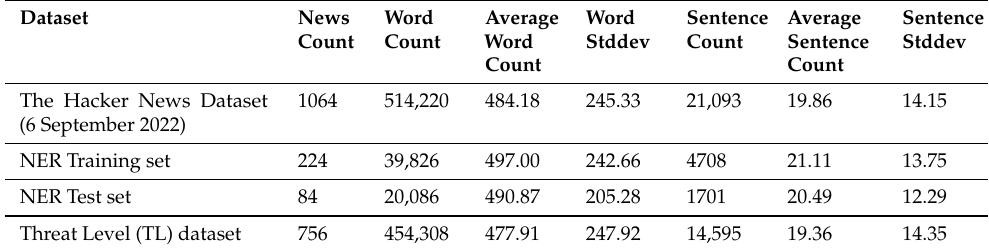
Table 6. Threat Assessment Datasets